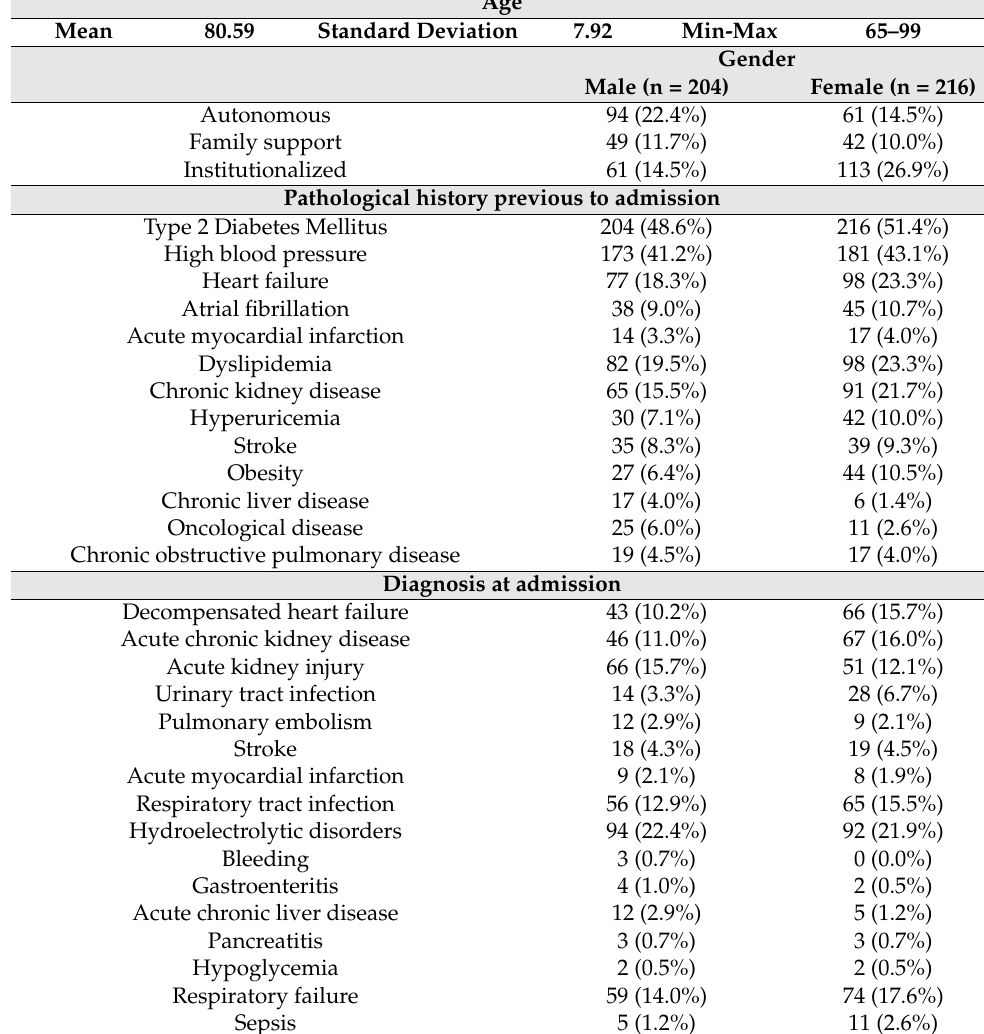
Table 1. Patients’ characteristics at